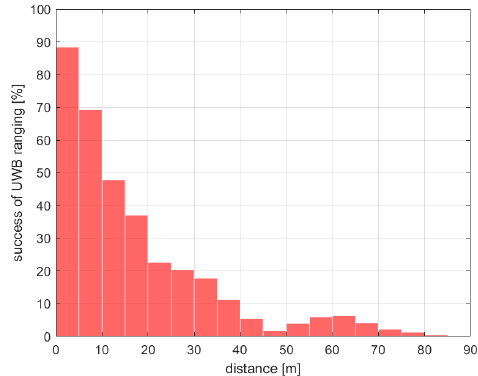
Figure 9. V2I TimeDomain range success rate varying the distance between the